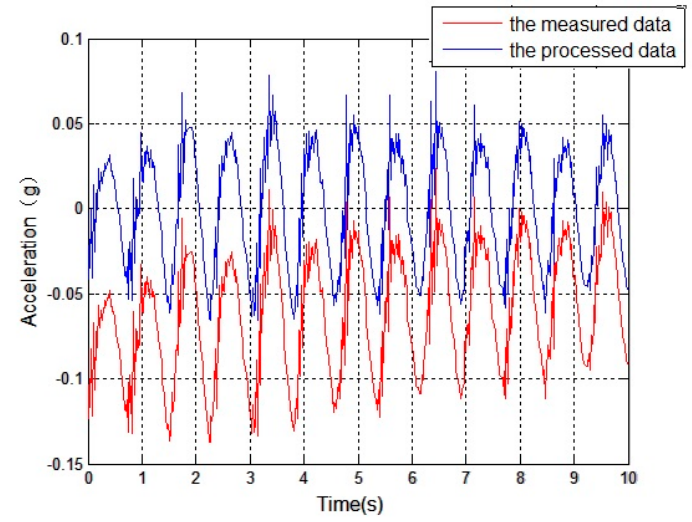
Figure 12. Comparison of the signals before and after being processed.